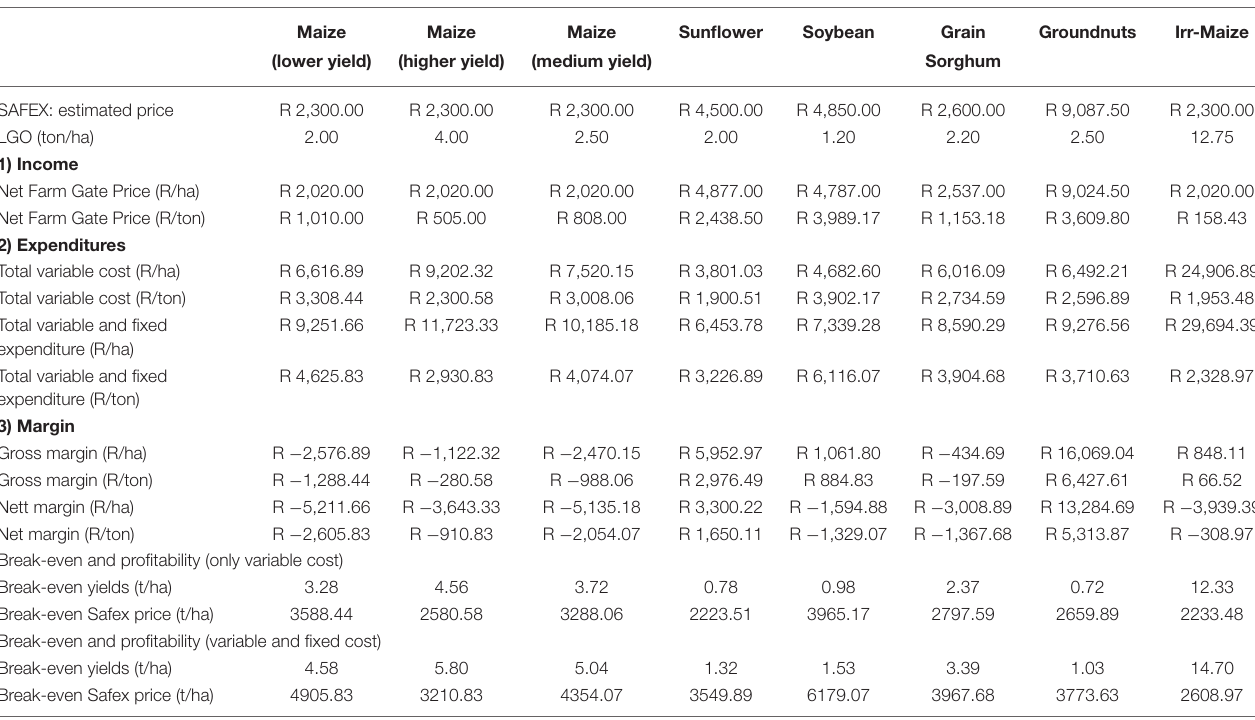
TABLE 2 | Cost-benefit analysis for selected summer crop production in Limpopo Province from the period 2014 to 2018. Summary Limpopo average cost budgets and income for selected summer crops cultivation for the period